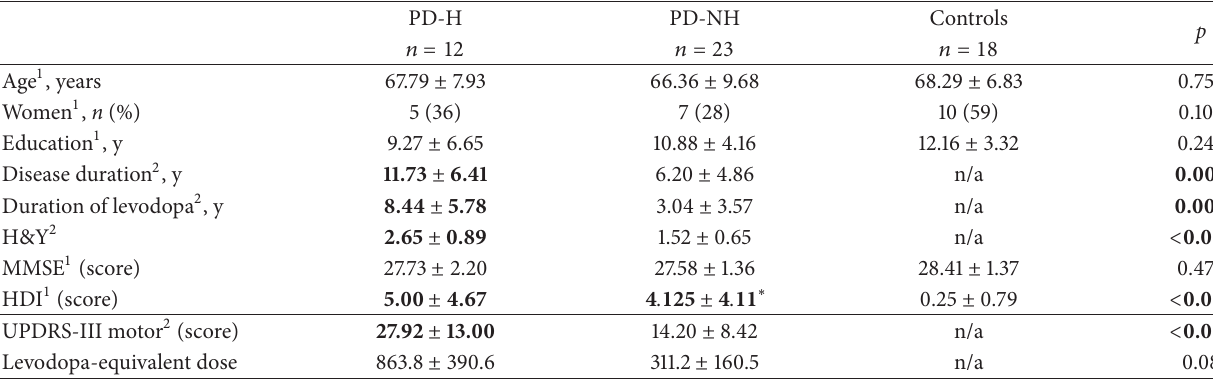
Table 1: Characteristics in PD-H, PD-NH, and